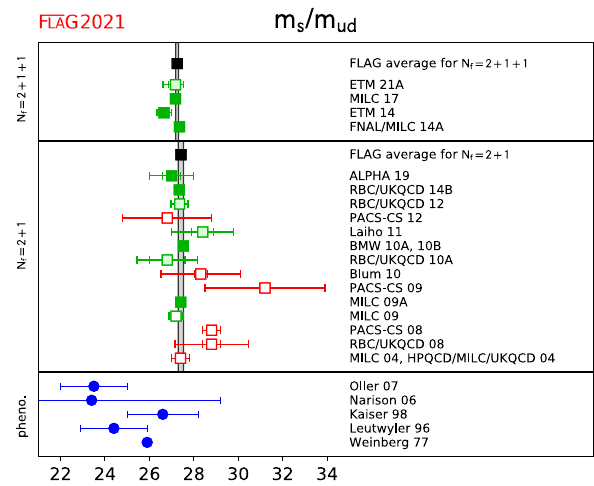
Fig. 3 Results for the ratio m s / m ud . The upper part indicates the lattice results listed in Table 8 together with the FLAG averages for each value of N f . The lower part shows results obtained from χ PT and sum rules